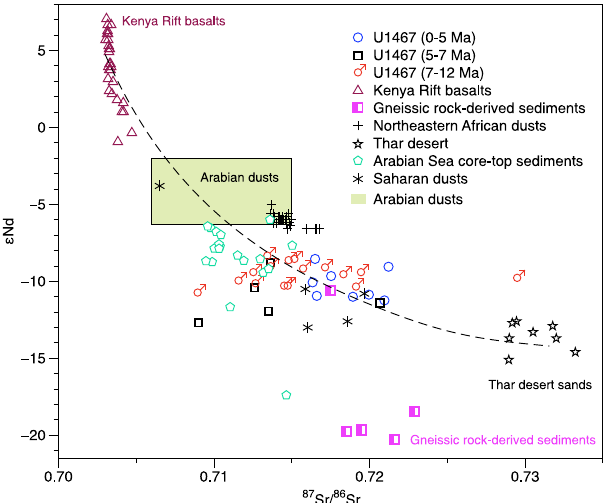
Fig. 2 | Sediment provenance discrimination of Site U1467. 87 Sr/ 86 Sr isotopic ratios versus ε Nd diagram for Site U1467 along with the potential sources of northeastern African rift 34 , gneissic rock-derived sediments in the southern Indian continent 19 , Saharan dusts 32 , northeastern African dusts 31 , Indian Thar desert 36 , Arabian dusts and the core-top sediments from the Arabian Sea 29 .